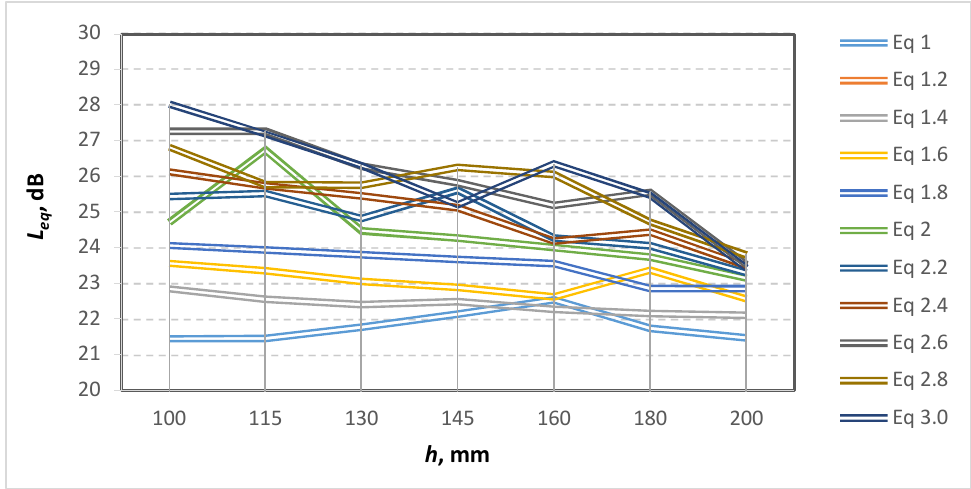
Figure 6. Equivalent value of the sound pressure level L eq (on the ordinate) for the different values of the central opening/inlet at the different values of a/b (on the abscissa are the different variants of a/b in ascending order).